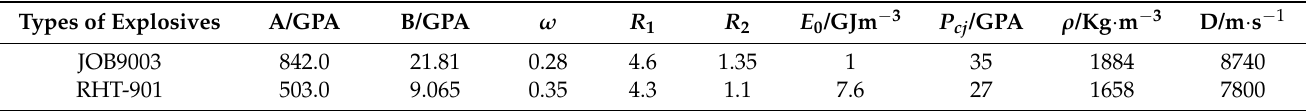
Table 3. JWL EOS parameters of the explosives